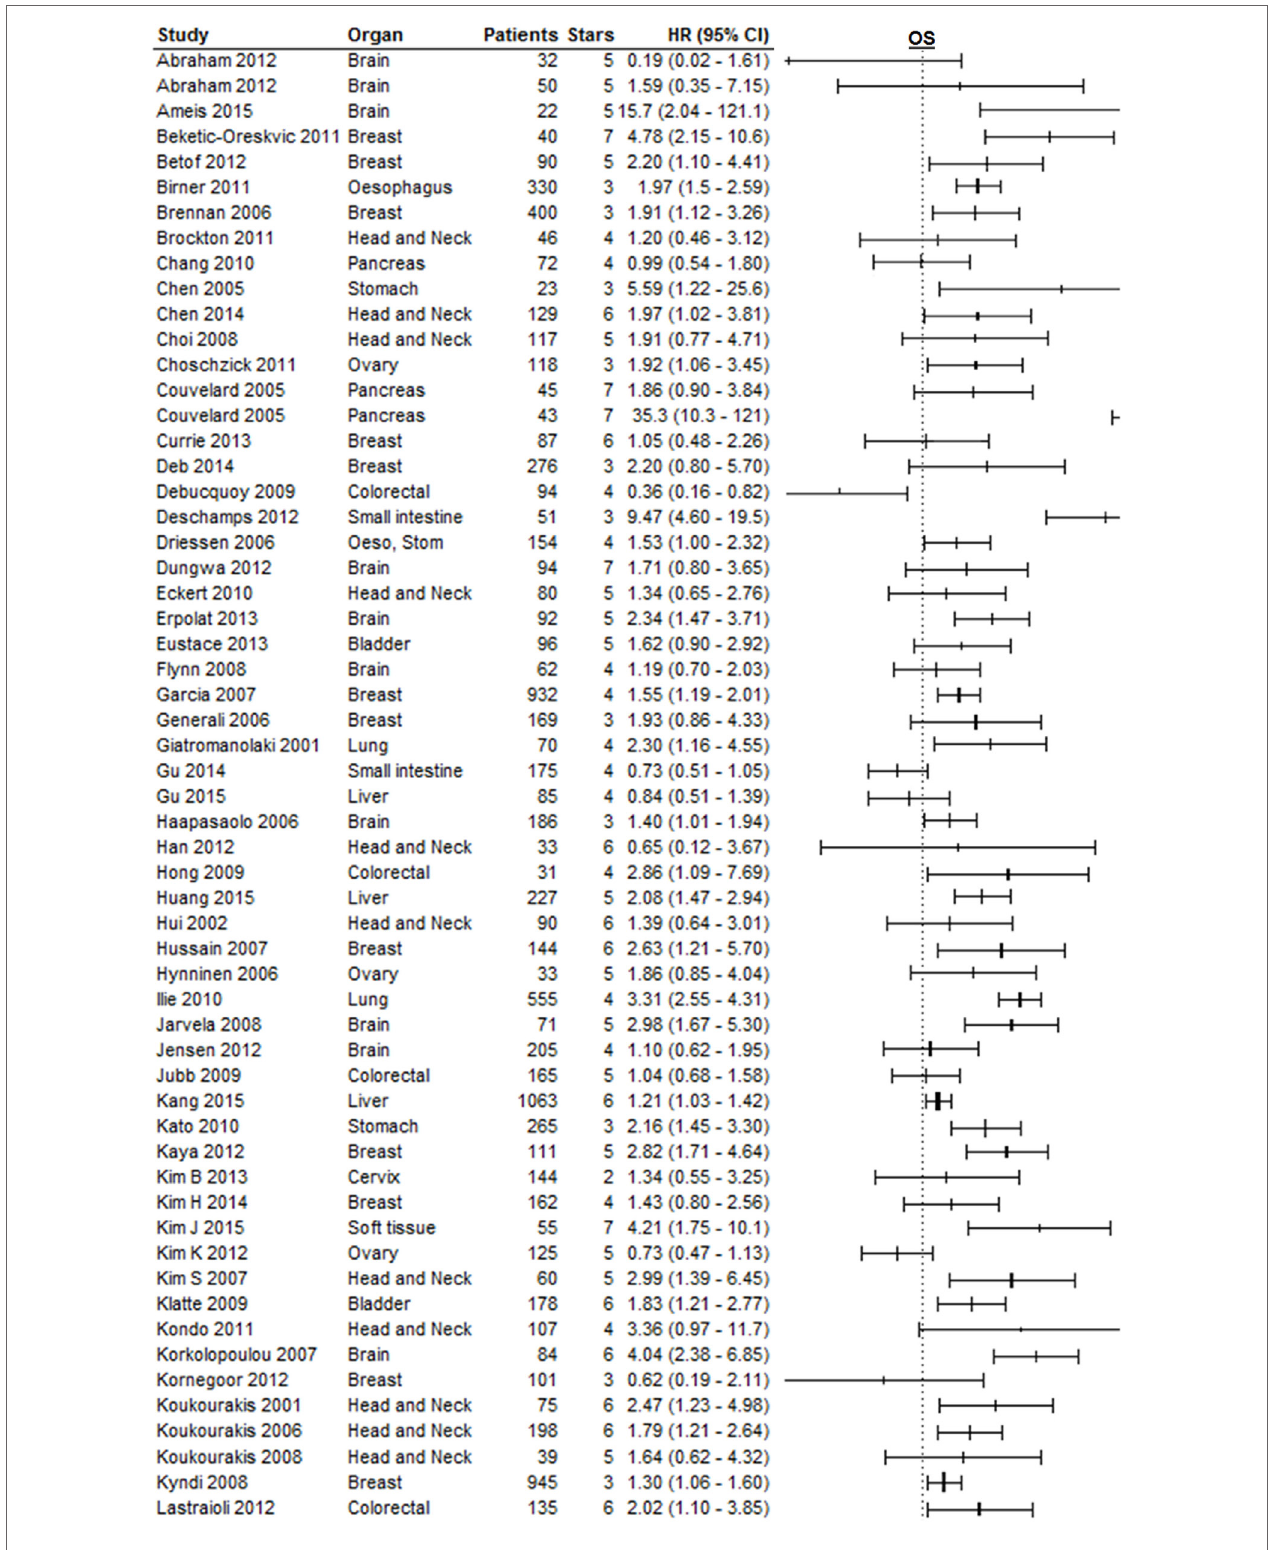
FiGURe 3 | Forest plot of the papers describing the association between CAiX expression and OS . Horizontal bars represent HR with corresponding 95%CI. Symbol size represents the assigned weight of the study. The overall HR with 95%CI is visualized with the diamond shape. Dashed line indicates no association between CAIX and prognosis. Esop, Stom, esophagus and stomach; GEP, gastroenteropancreatic tract (25–27, 29, 30, 44–129).